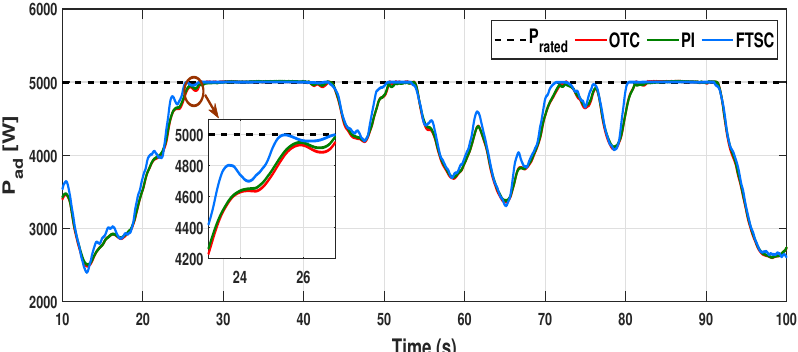
Figure 19. Aerodynamic power captured by the system under different control schemes for varying wind profile case-II .